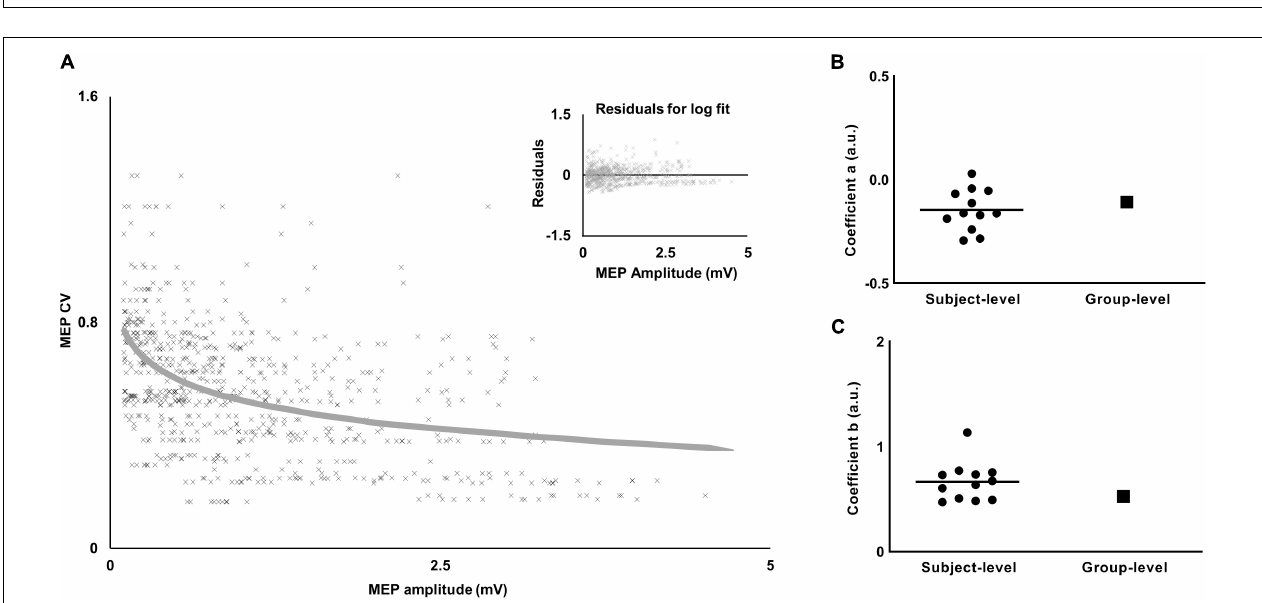
FIGURE 4 | Relationship between variability (CV) and amplitude of MEP. (A) The decrease in MEP CV with increase in MEP amplitude was characterized by a logarithmic fit. Inset plot shows a trend in residuals for the logarithmic fit. (B) Comparison of the slope-coefficient for subject-level versus group-level models. (C) Comparison of the intercept-coefficient for subject-level versus group-level models. For the subject-level model, each dot represents coefficient from an individual subject and the horizontal line represents the mean.